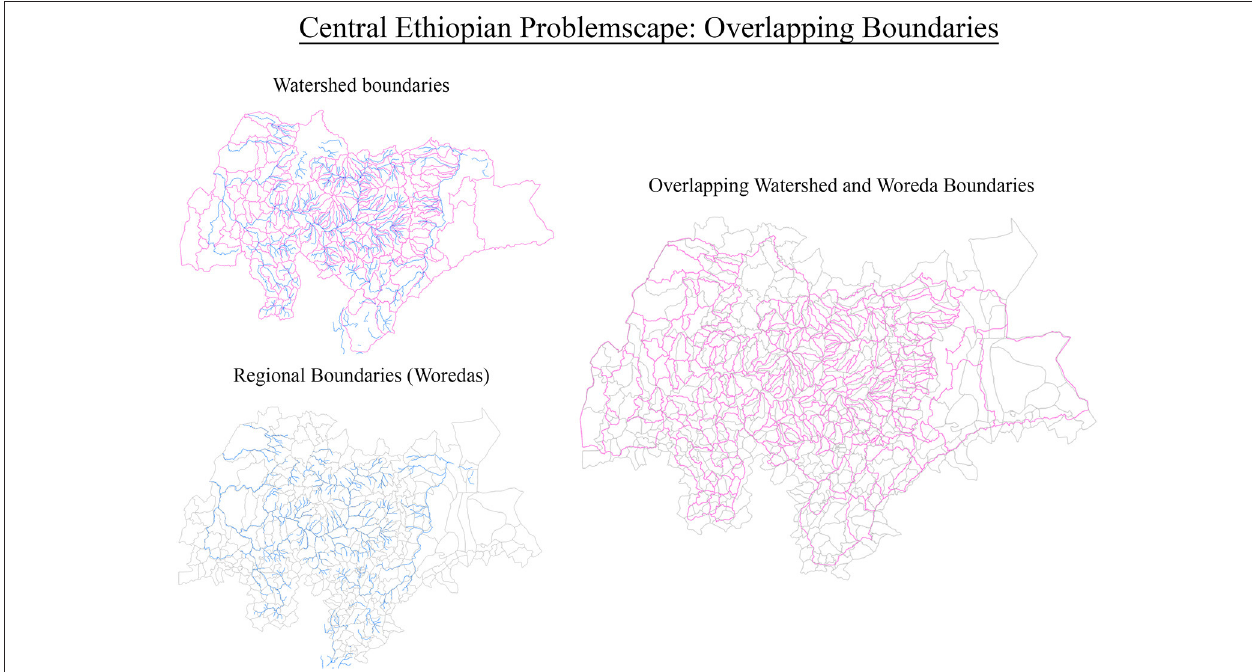
FIGURE 6 | Overlapping